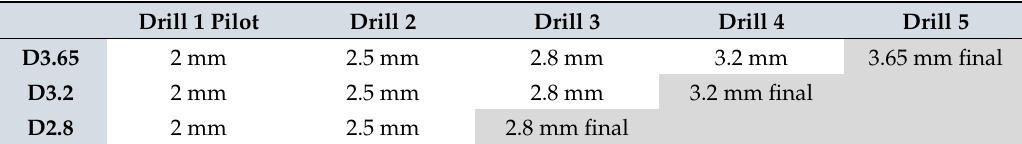
Table 1. Implant bed preparation protocols for the study groups. The values represent the drill diameters (in mm).